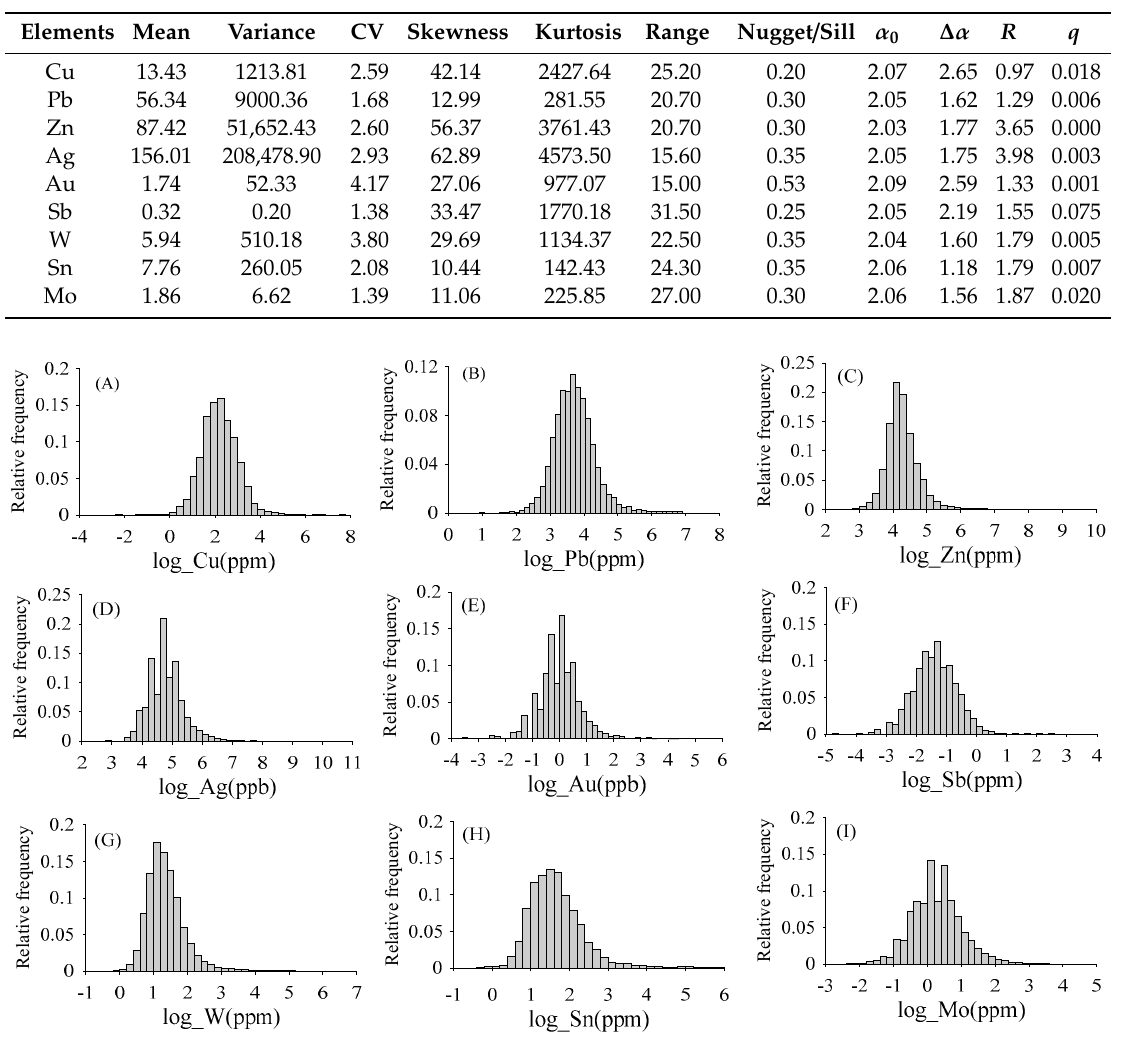
Table 1. The statistical parameters characterizing the frequency and spatial distribution properties of the 9 selected elements.